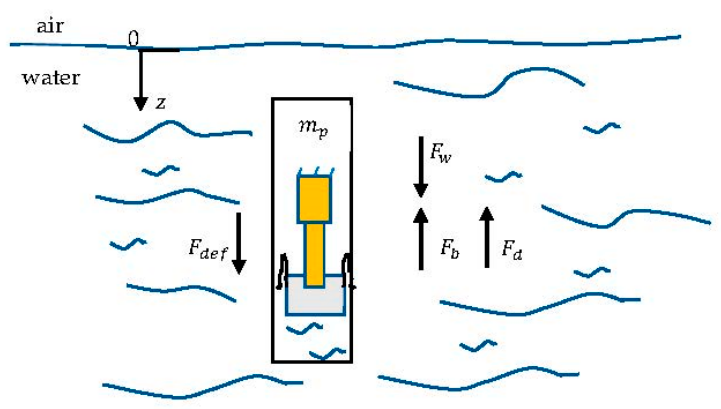
Figure 5. Forces acting on the prototype structure.